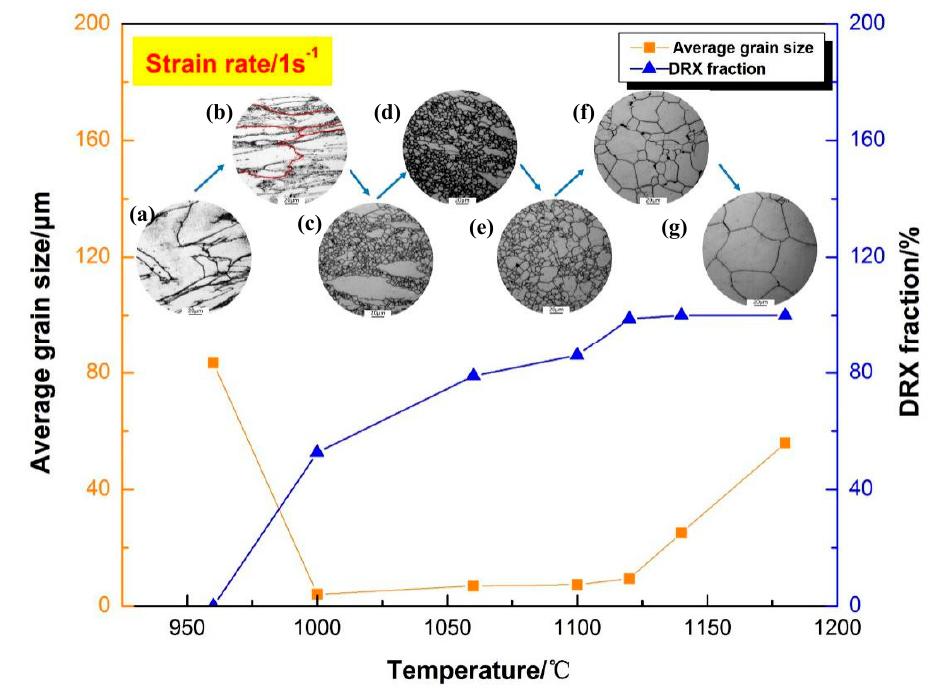
Figure 9. Schematic diagram of grain size, dynamic recrystallization (DRX) fraction and optical microstructure of the specimens deformed at the strain rate of 1 s − 1 : ( a ) 960 °C, ( b ) 1000 °C, ( c ) 1060 °C, ( d ) 1100 °C, ( e ) 1120 °C, ( f ) 1140 °C, ( g ) 1180 °C.